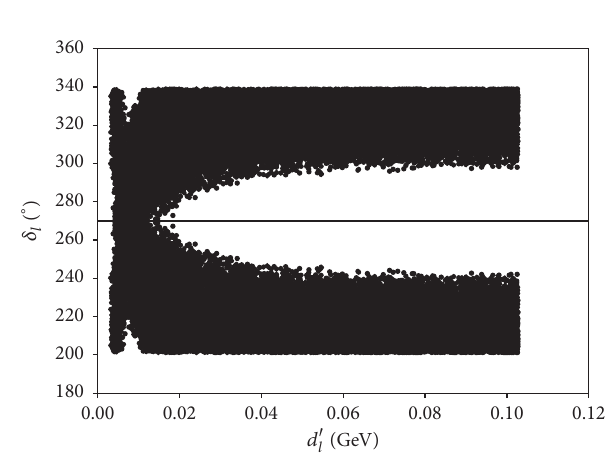
Figure 10: 𝛿 𝑙 versus 𝑓 󸀠 𝑙 for Case